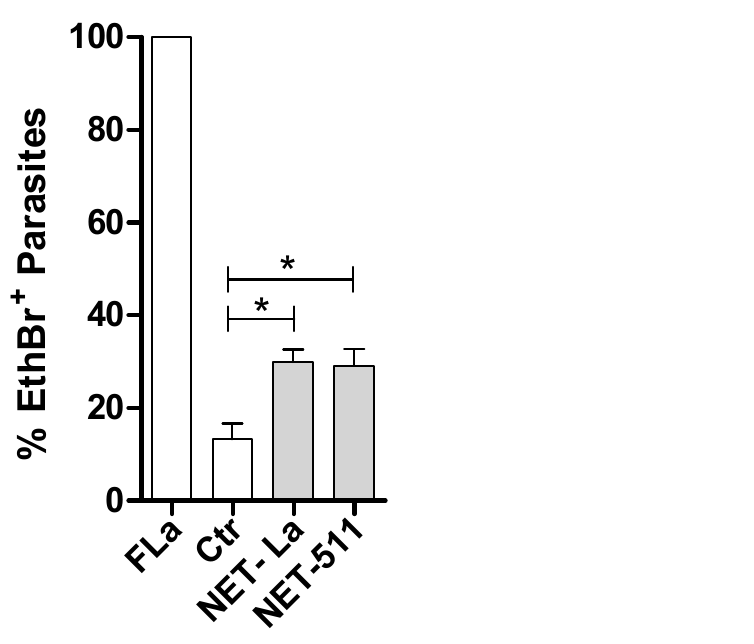
Figure 7. Leishmania killing induced by NET-rich supernatants. Promastigotes (1 × 10 6 ) were incu- bated or not for 2h with NET-rich supernatants obtained after 4h of stimulation with L. amazonensis or LM 511 at 37 ◦ C and 5% CO 2 . Then, parasites were stained with ethidium homodimer-1 (EthD-1) for 30min at 37 ◦ C and 5% CO 2 and analyzed via flow cytometry. Leishmania fixed with 4% formaldehyde (Fla, dead parasites) served as the positive control (100% of death). The results are shown as the mean ± SEM of 2 donors. * p < 0.05.